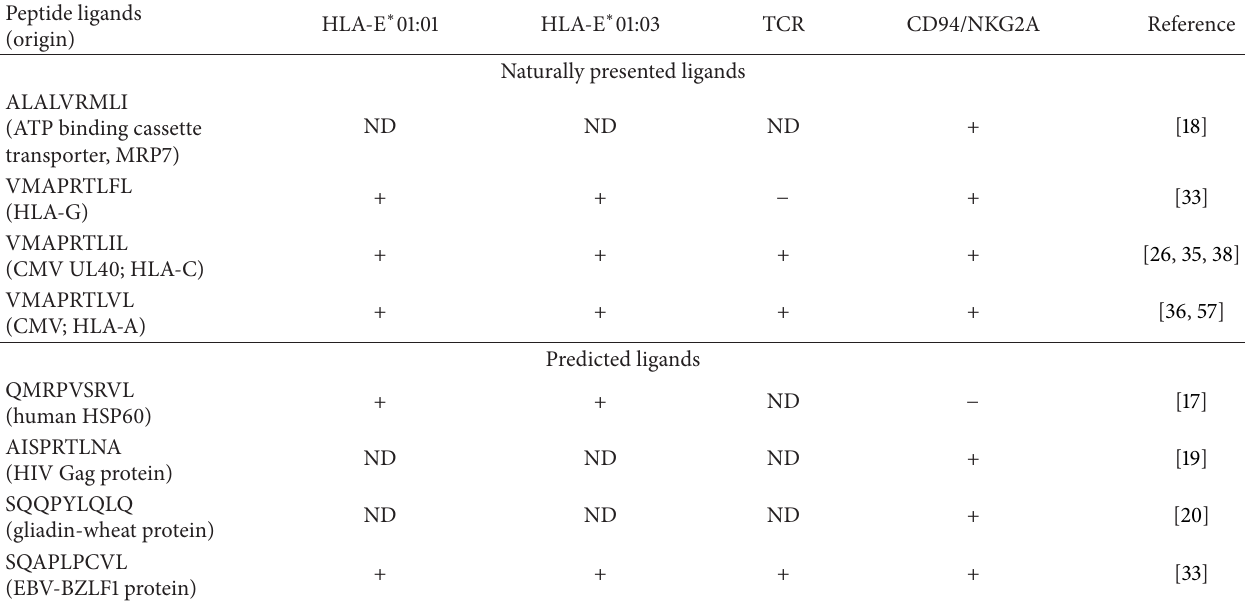
Table 1: HLA-E peptide